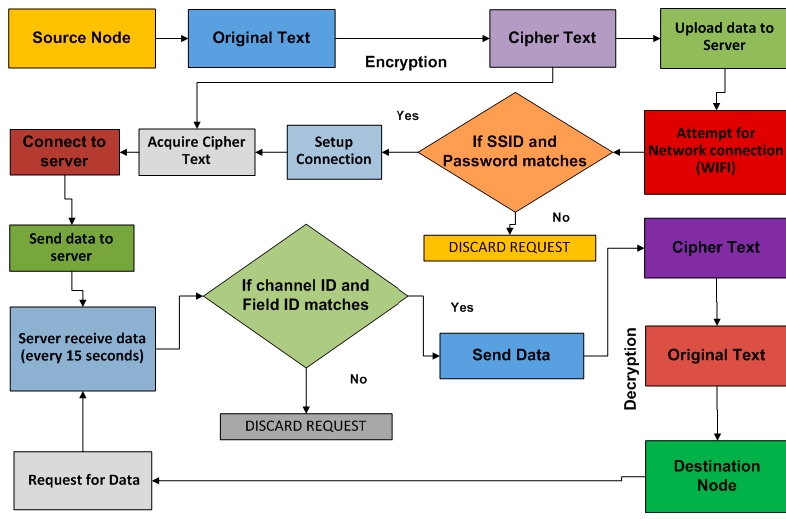
Figure 3. Source-destination data communication model.